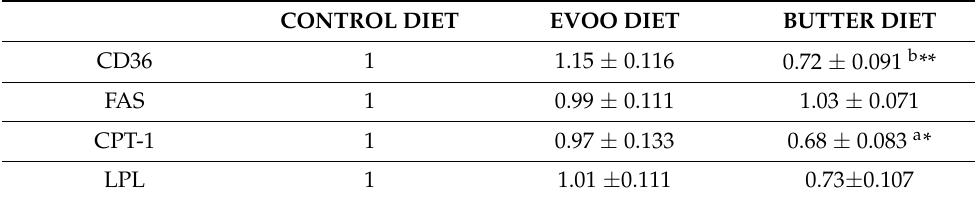
Table 3. Mean values ± SEMs of mRNA expression (relative RNA level) of different genes regulators of lipid metabolism (CD36: cluster of differentiation 36; FAS: fatty acid synthase; CPT-1: carnitine palmitoyltransferase I; and PLP: lipoprotein lipase) in liver samples of the three groups of animals (the control, butter, and EVOO diets). a, b: significant differences between EVOO, butter, and control and between EVOO and butter, respectively. * p < 0.05 and ** p < 0.01. CONTROL DIET EVOO DIET CONTROL